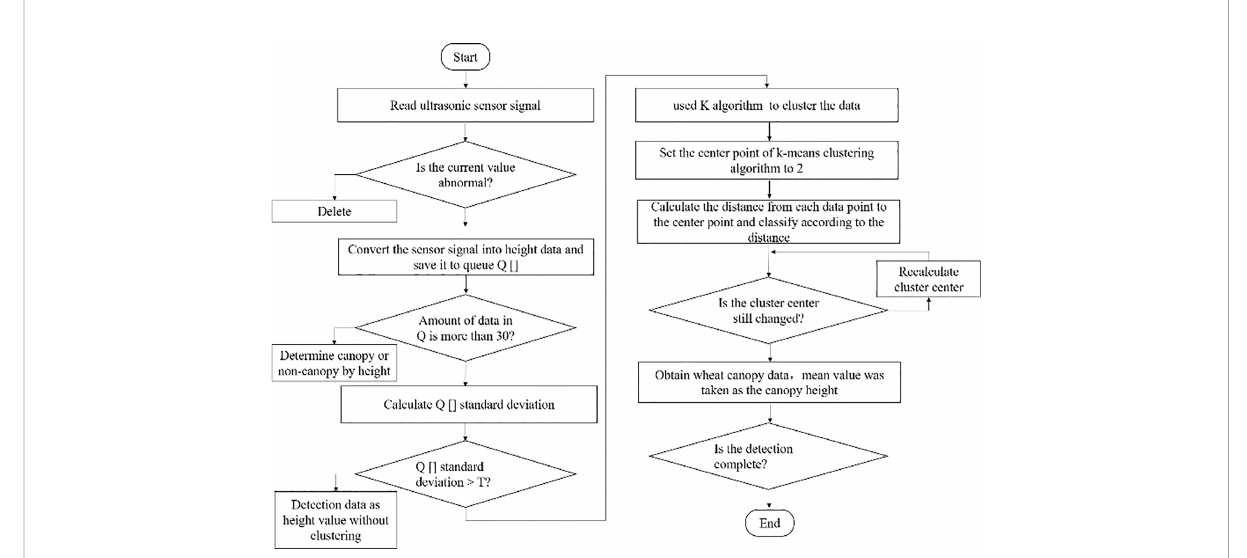
FIGURE 6 Calculation fl ow of canopy height based on K-means algorithm. The overall idea of the canopy height calculation process based on K-means algorithm is to fi rst judge whether the detection signal is abnormal data according to the real-time signal of the ultrasonic sensor, and then